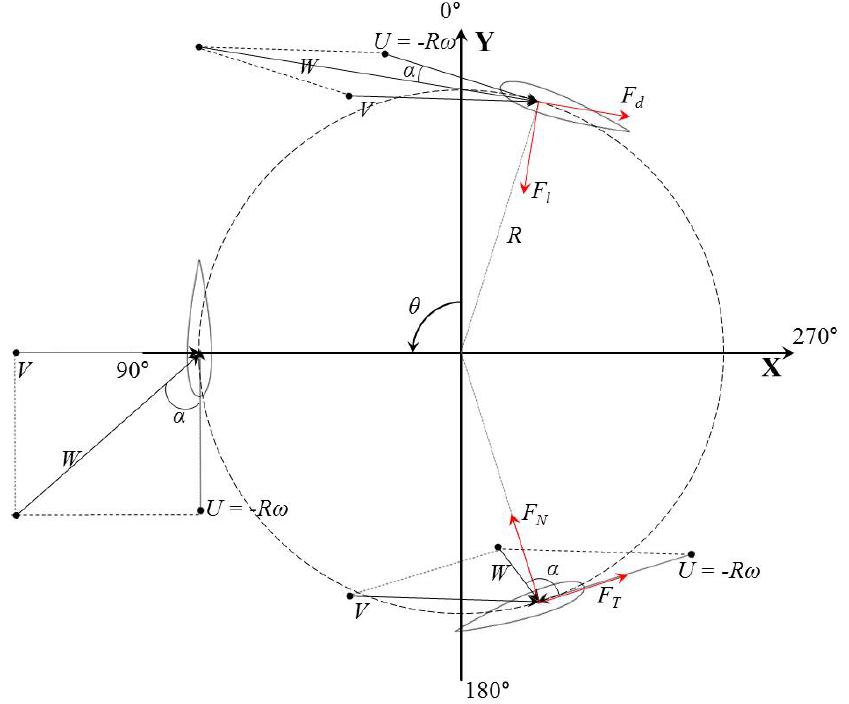
Figure 2. Force and velocities acting on the vertical wind turbine for various azimuth angles.